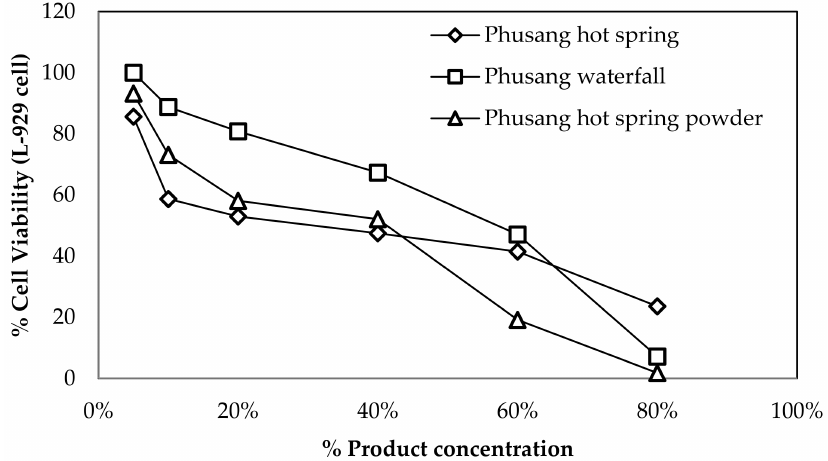
Figure 4. Effects of different concentrations of the product (Phusang hot spring water, Phusang wa- terfall water and Phusang hot spring powder) on the viability of L-929 cells after 24 h, as determined using MTT assays. Note: Phusang hot spring = Phusang hot spring water, Phusang waterfall = Phusang waterfall water.